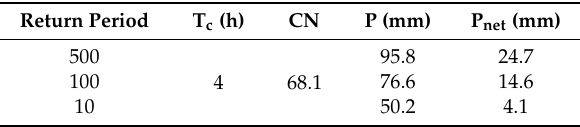
Table 2. Excess rainfall amounts determined by the NRCS-CN and CN4GA methods.